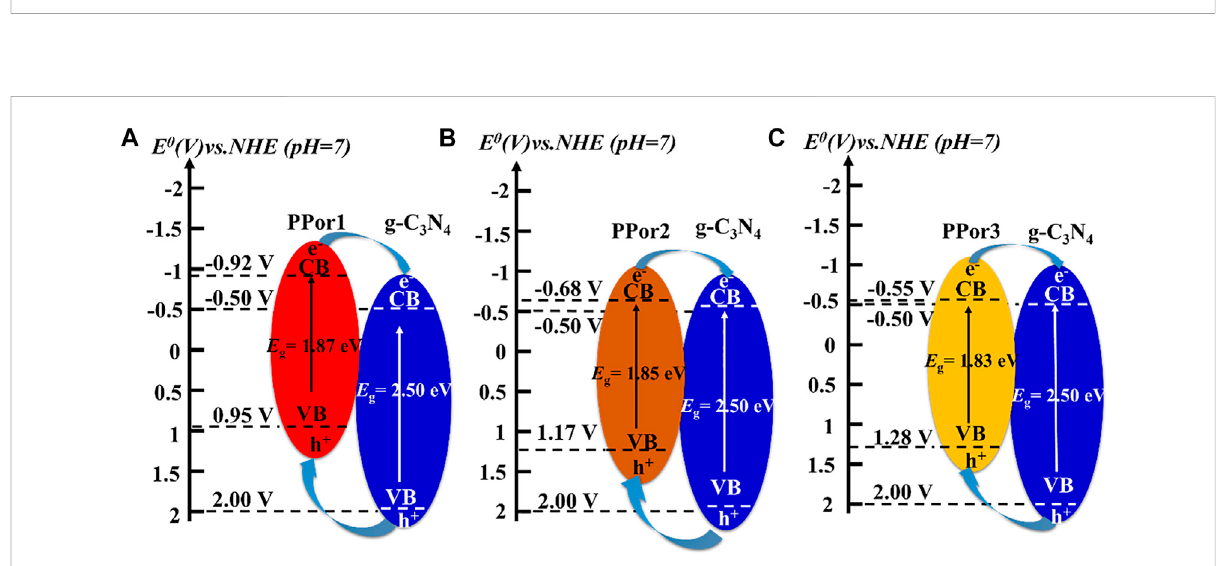
FIGURE 8 The schematic diagrams of the proposed electron transfer under visible light irradiation in (A) PPor1-g-C 3 N 4 , (B) PPor2-g-C 3 N 4 and (C) PPor3- g-C 3 N 4